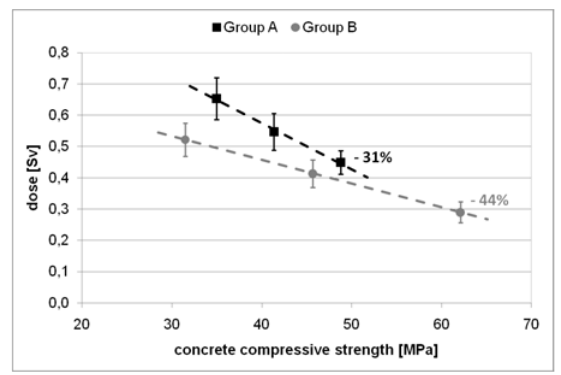
Figure 3. Effective dose behind 25 cm thick concrete of different compressive strength (SPOT simulation).